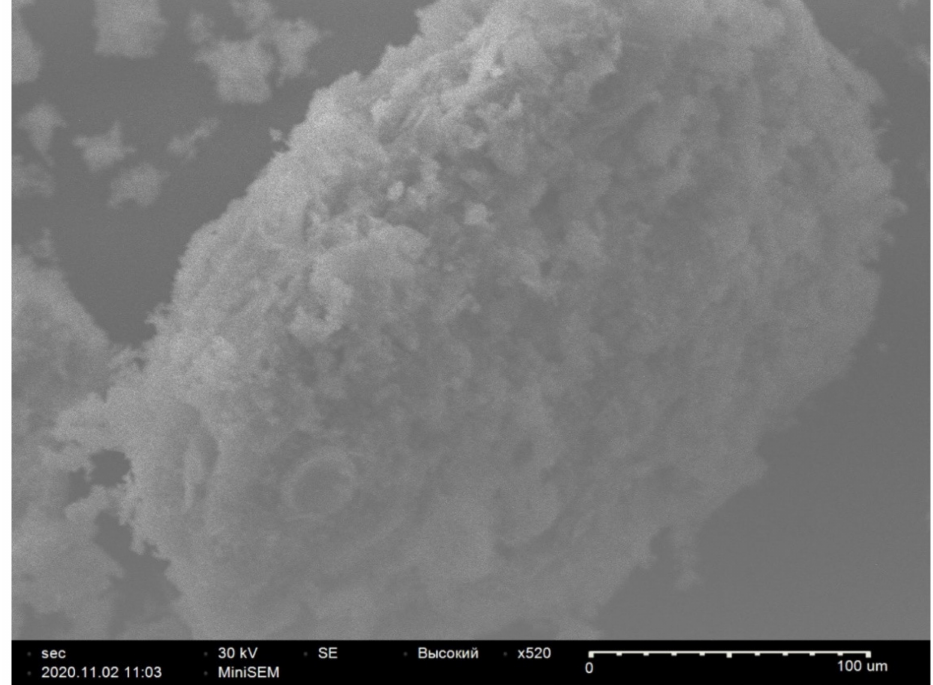
Figure 4. The surface of diatomite (SNE 4500M